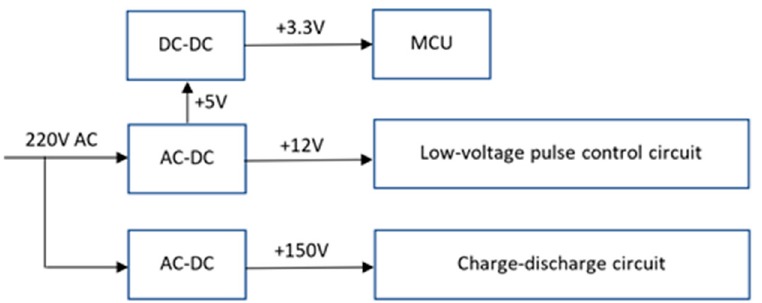
Figure 6. The schematics of the driver circuit.